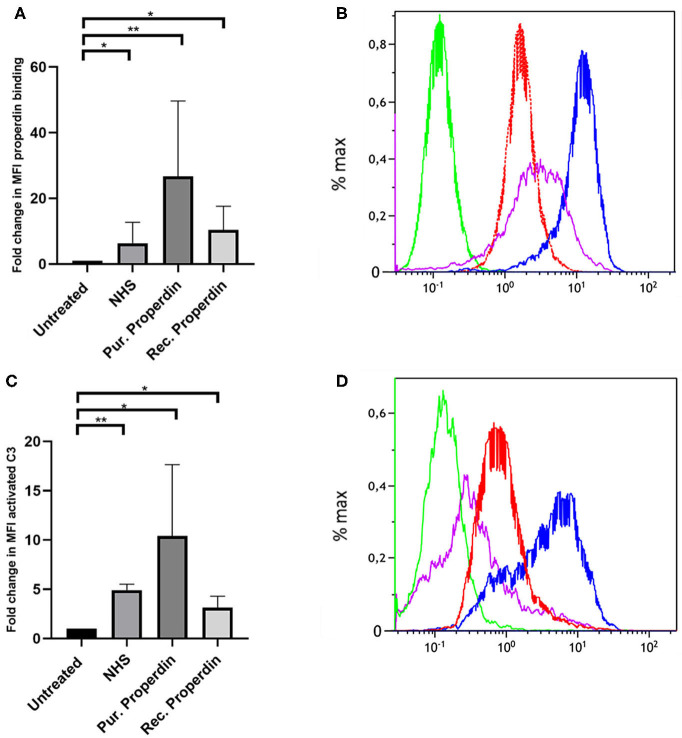
Properdin from various sources bind with PTEC in vitro and functions as docking station for alternative pathway complement activation. (A) Properdin present in 50% normal human serum (NHS), purified properdin and recombinant properdin show binding with PTEC in comparison to the negative control. Data presented as fold change compared to the untreated control and analyzed by the Wilcoxon trank sum test (*P < 0.05, **P < 0.01). Asterisks above the capped lines denote significant differences between the untreated samples and the properdin binding from different sources (n = 10). (B) Representative flow cytometry experiment for properdin binding from 50% NHS (red line), purified properdin (blue line) and recombinant properdin (purple line) in comparison the untreated sample (green line). Data represented as % max (data normalized for the peak at 100%). (C) Complement C3 activation via properdin from NHS, purified properdin and recombinant properdin shows complement activation via the alternative pathway. Data presented as fold change compared to the untreated control and analyzed as described in (A) (n = 6). (D) Representative flow cytometry experiment for complement C3 activation via NHS (red line), purified properdin (blue line), recombinant properdin (purple line) and the untreated sample (green line).